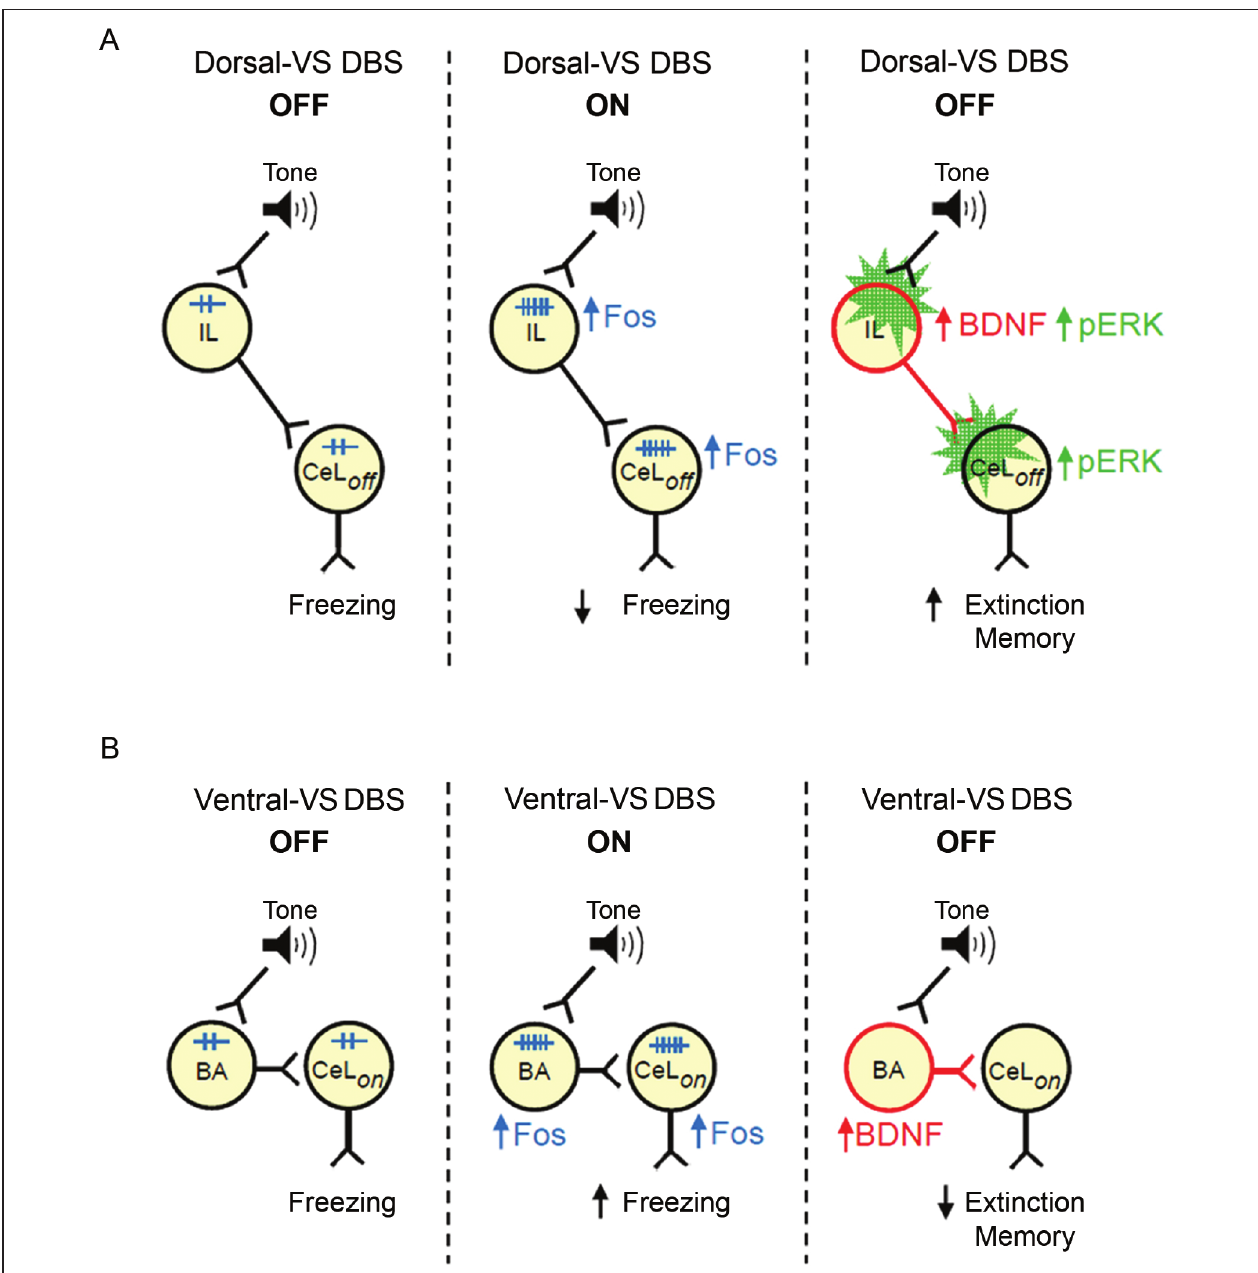
FIGURE 4 | Suggested models of how DBS of dorsal-VS and ventral-VS affect fear. (A) Middle: DBS of dorsal-VS (ON) increases neuronal activity (Fos) in the IL-CeL off circuit, decreasing freezing to a conditioned tone. Right: DBS of dorsal-VS also increases BDNF in IL and induces plasticity (pERK) in IL and CeL off (Rodriguez-Romaguera et al., 2012), thereby enhancing extinction